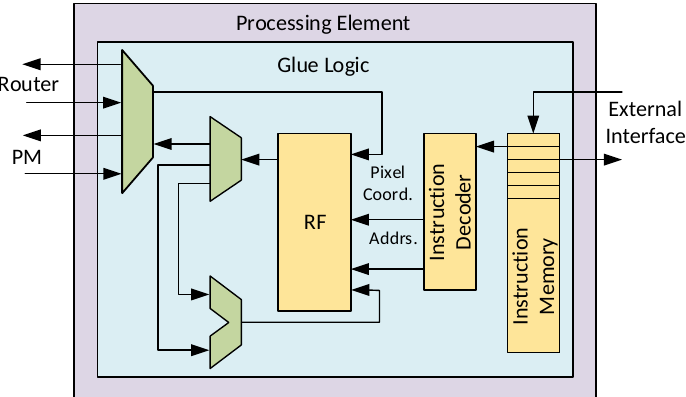
Figure 6. Processing element microarchitecture for P-type and R-type instructions.